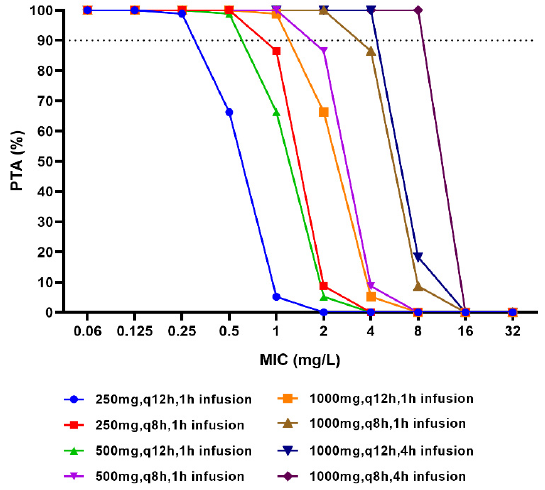
Figure 6. PTA results of doripenem dosing regimens. The lines show calculated PTA of doripenem in each simulated dosage regimen.